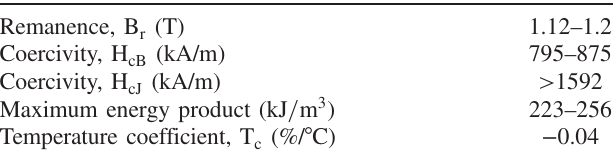
TABLE II. Specification of Sm 2 Co 17